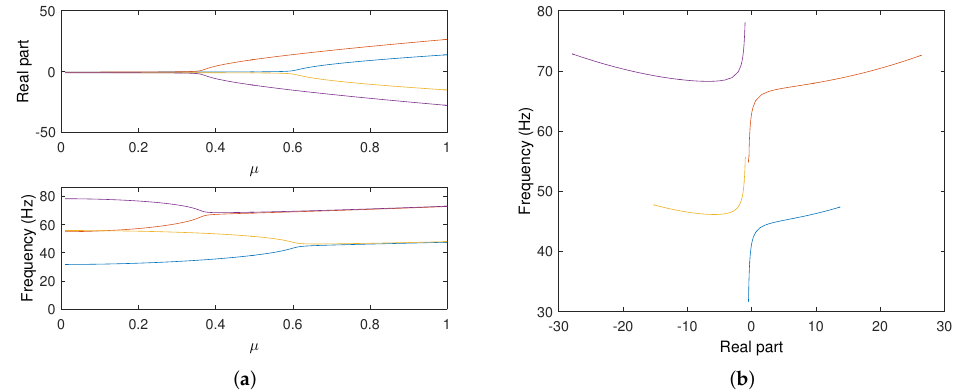
Figure 2. Stability analysis of the mechanical system under study. ( a ) Evolution of real parts and frequencies versus the friction coefficient. ( b ) Complex plan (